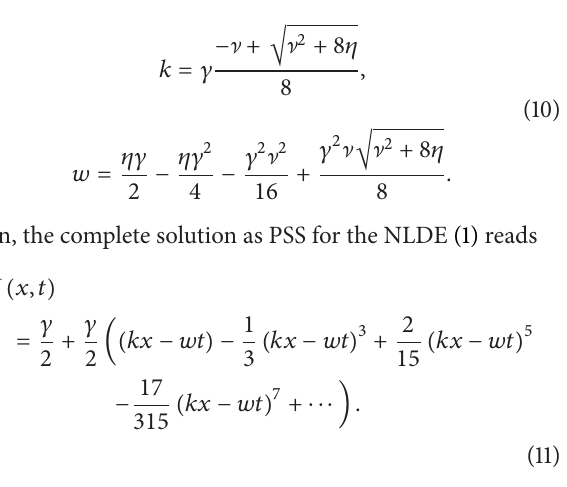
Figure 2: Trajectories of the approximate solution of the Burgers- Huxley equation, (1), with 𝛿 = 1 , 𝛾 = 0.001 , ] = 1 , and 𝜂 = 1 , for 𝑥 = 0.9